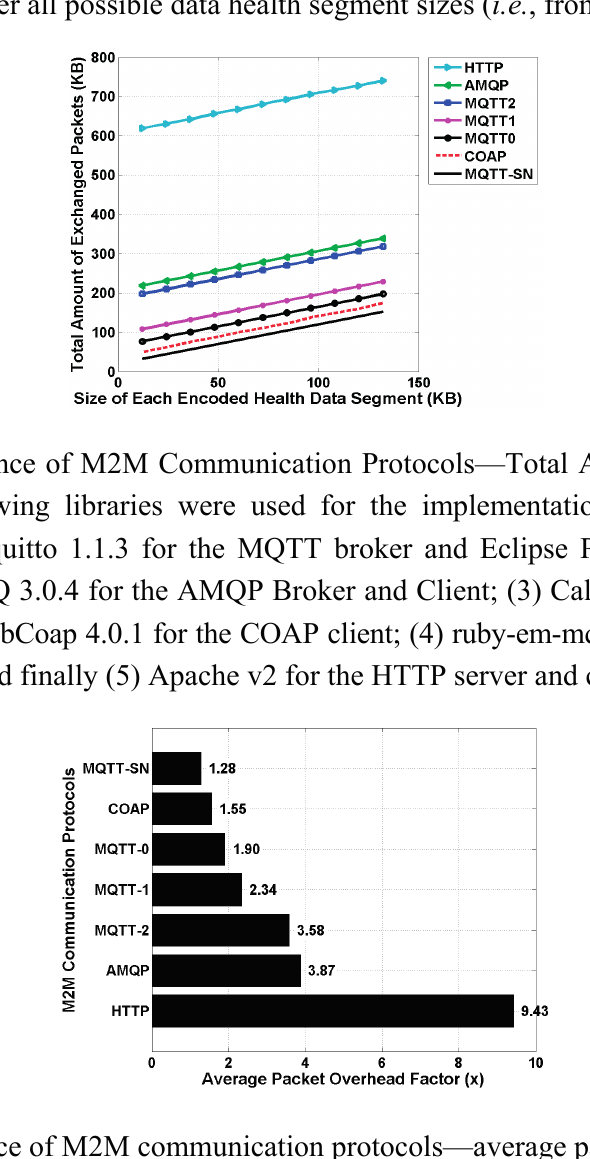
Figure 10. Performance of M2M communication protocols—average packets overhead